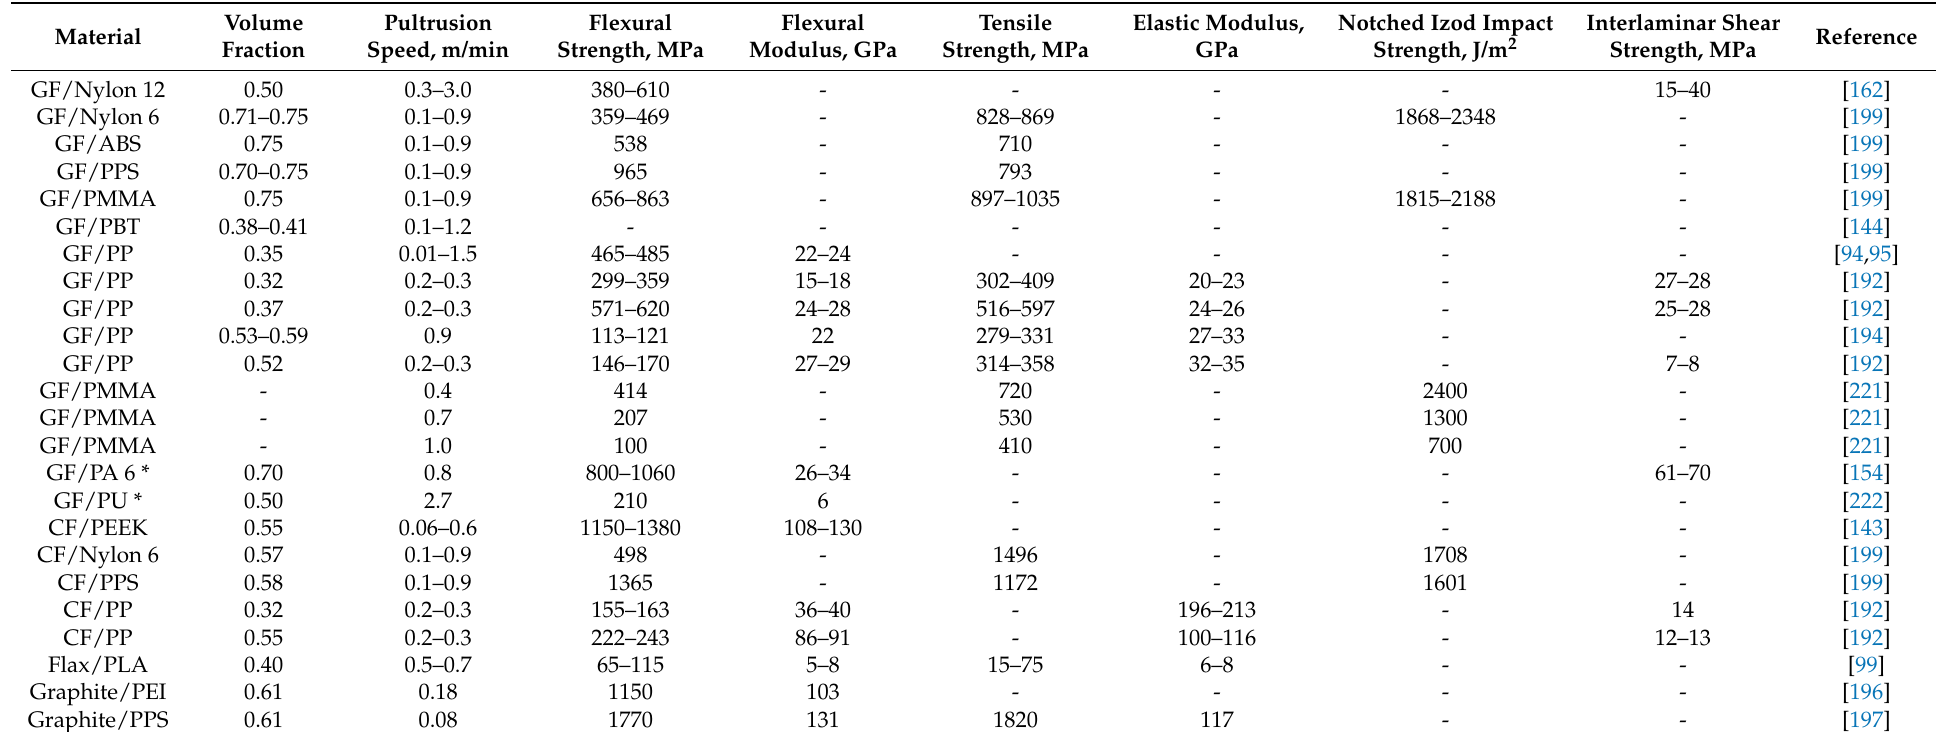
Table 3. Mechanical properties of thermoplastic pultruded